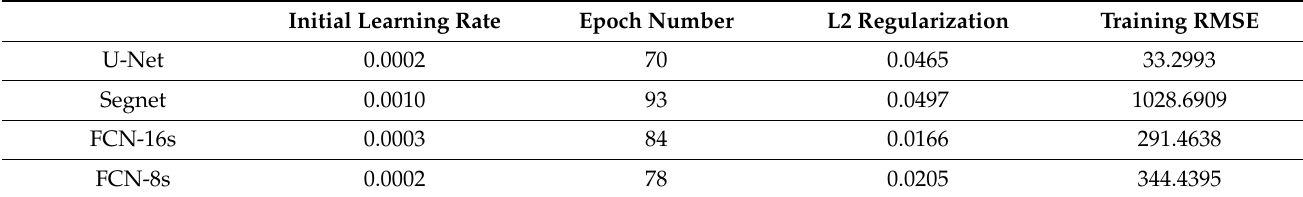
Table 1. Summary of other parameters for the networks.